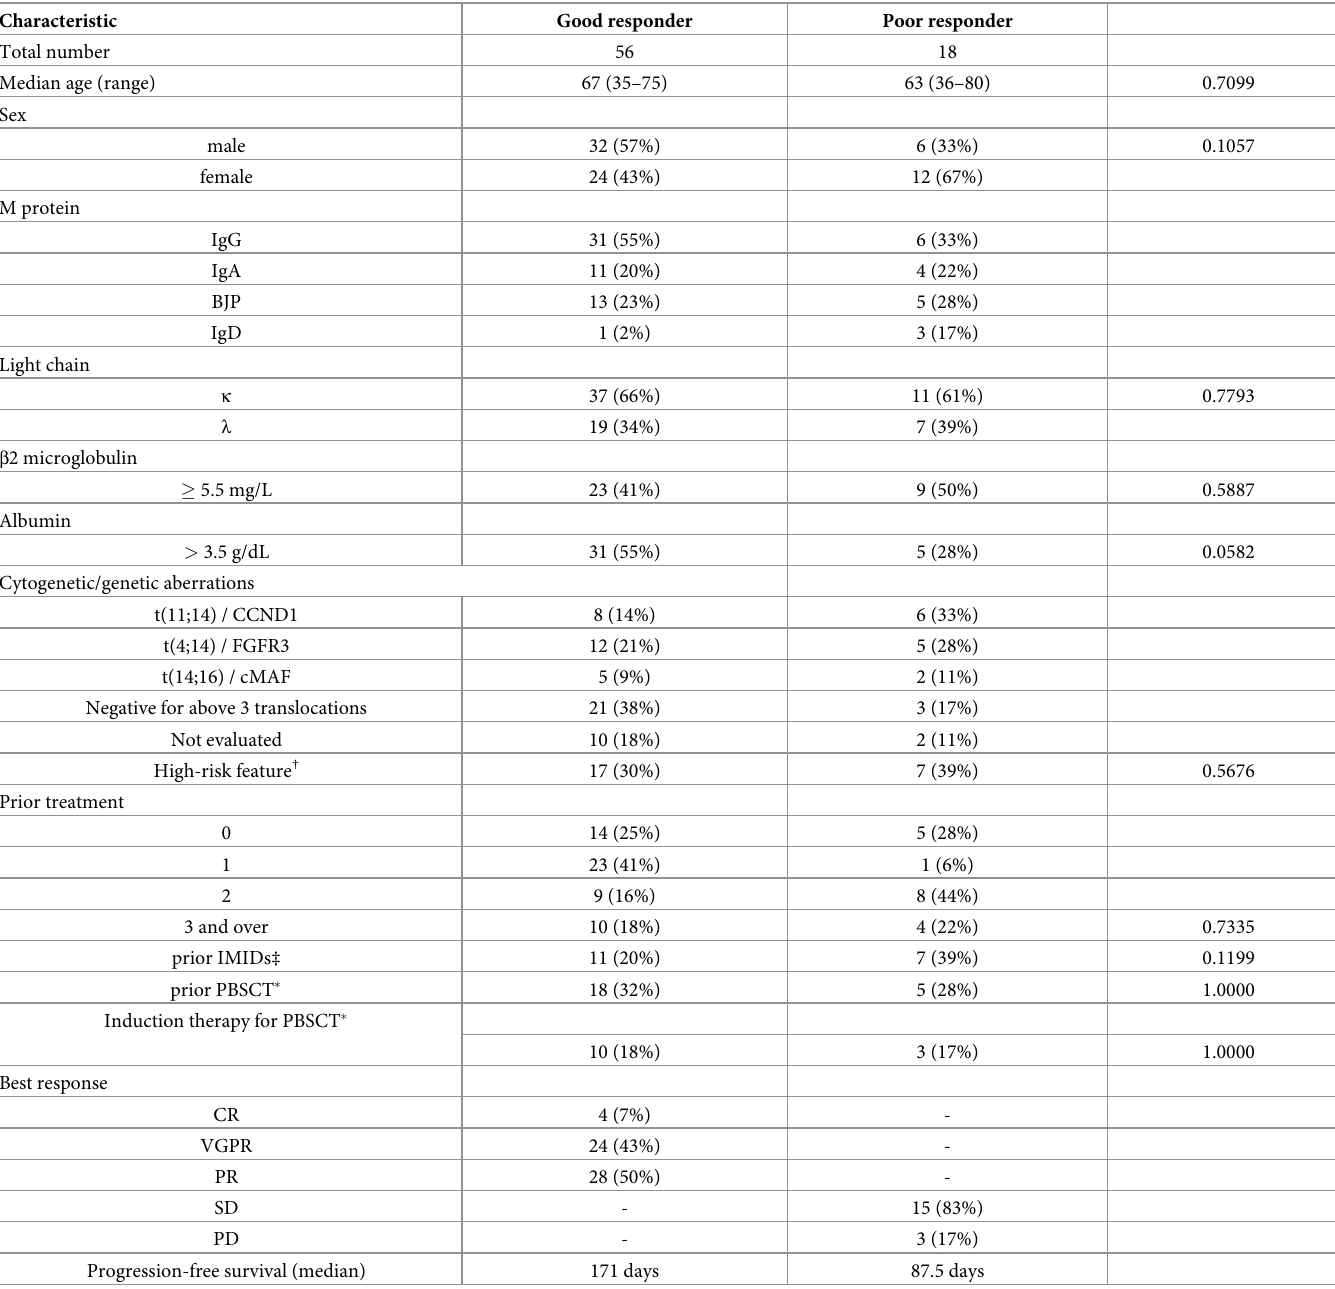
Table 1. Patient